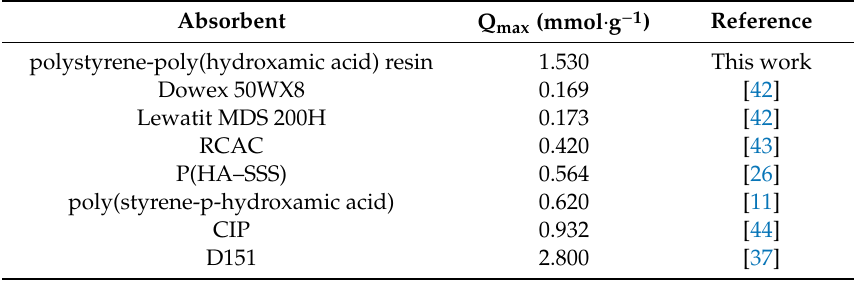
Table 5. Comparison of maximum adsorption capacity of Ce(III) on various